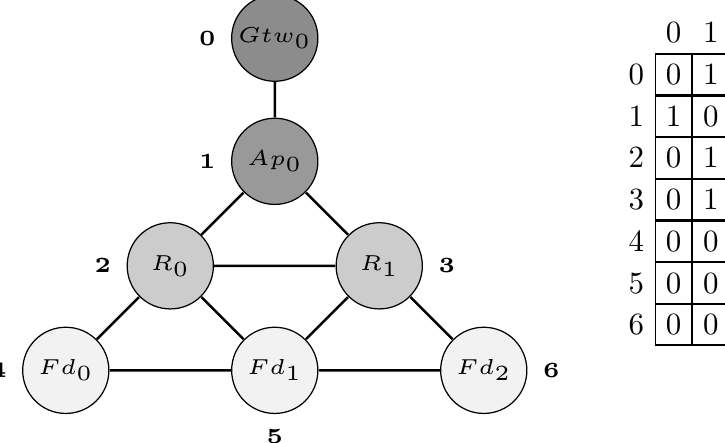
Figure 5. Example of a Wireless Sensor Network represented through a graph and its respective adjacency